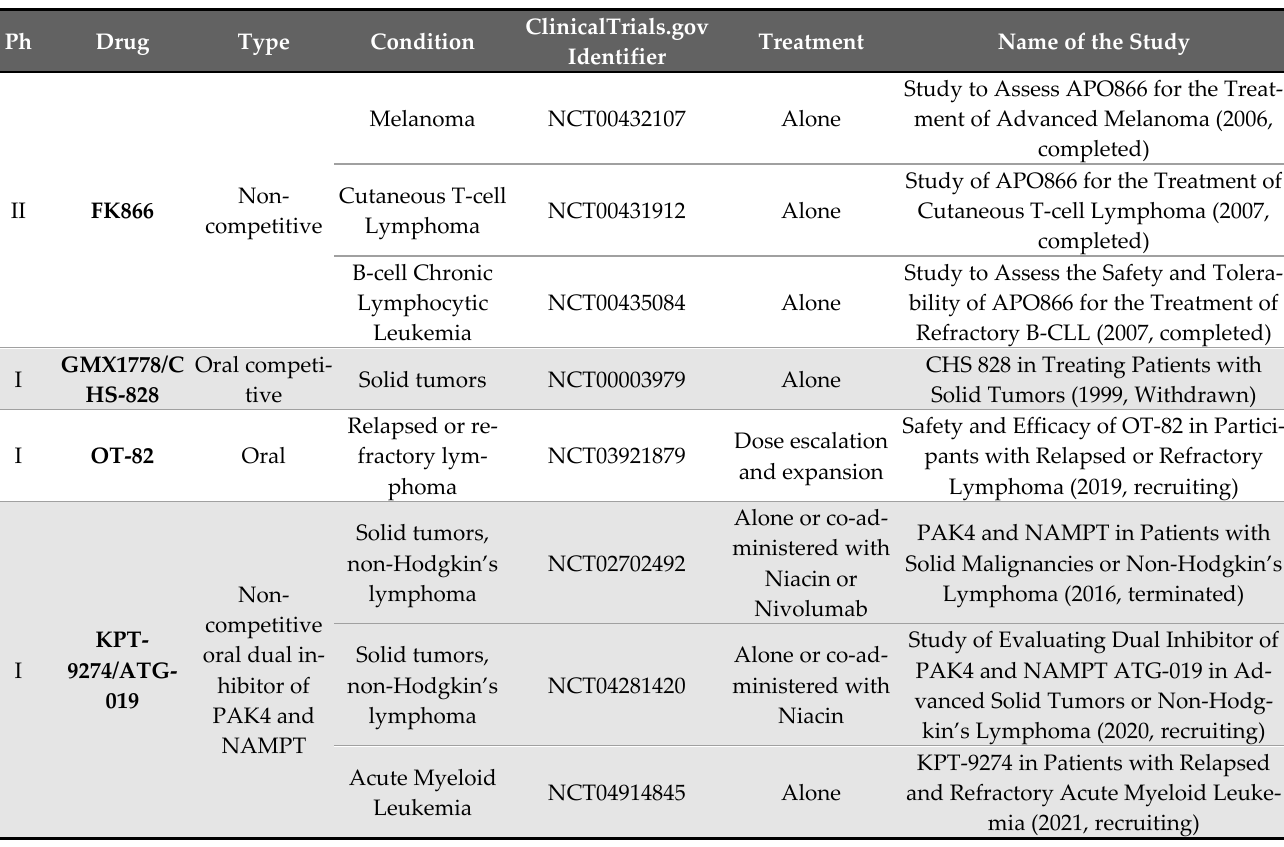
Table 1. NAMPT inhibitors in clinical trials.